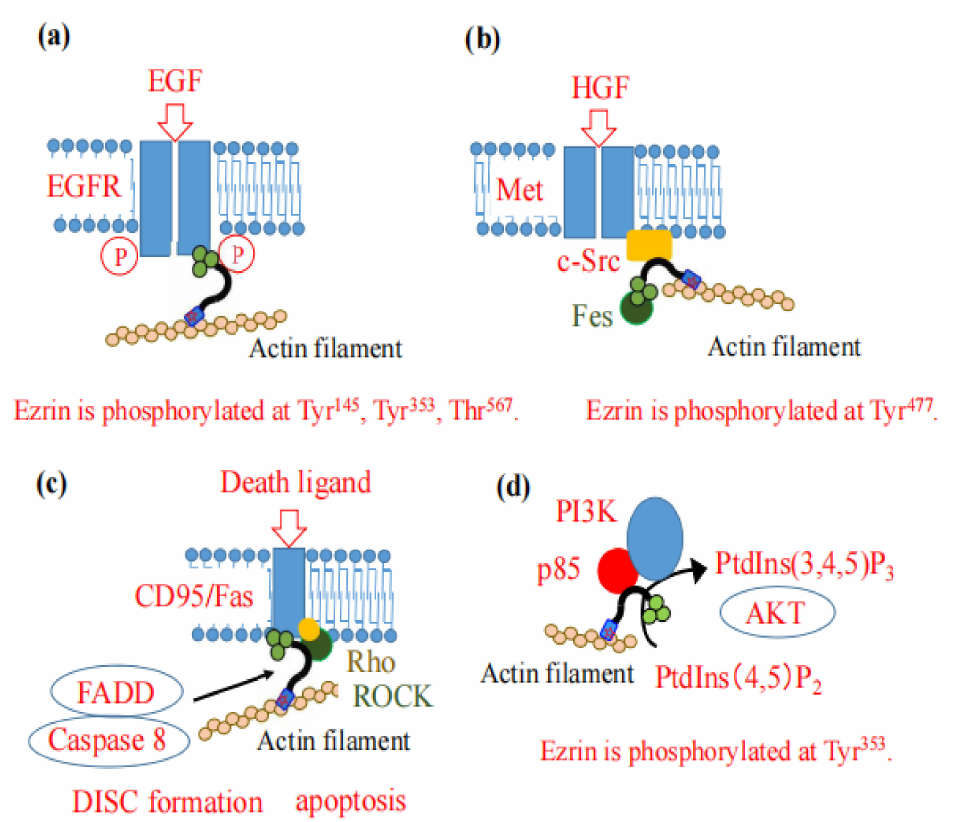
Figure 6. Ezrin is involved in several patterns of signal transduction. ( a ) In EGF signaling, ezrin cross-links the EGFR (shown by a couple of blue boxes) and actin filaments. In this process, ezrin itself is phosphorylated and activated by EGFR and other kinase(s) at Tyr 145 , Tyr 353 and Thr 567 . ( b ) In HGF signaling, HGF binds its receptor tyrosine kinase, Met (shown by a couple of blue boxes), which phosphorylates a non-receptor tyrosine kinase, c-Src (shown by a yellow box). Ezrin is phosphorylated by c-Src at Tyr 477 , and interacts with Fes tyrosine kinase (shown by a green circle). Thus, Fes is indirectly cross-linked with the actin cytoskeleton, recruited at the sites of cell-cell contact, and functions in cell invasion and metastasis. ( c ) Ezrin cross-links the receptor of death ligand, CD95/Fas (shown by a blue box), and the actin cytoskeleton, which is followed by the association of FADD and caspase 8 to form the DISC complex for apoptosis. Rho (shown by a yellow circle) and ROCK (shown by a green box) also associate with the complex. ( d ) Ezrin binds to the regulatory subunit of PI3-kinase, p85 (shown by a red circle). PI3-kinase synthesizes PtdIns(3,4,5)P 3 , which activates its downstream target, protein kinase AKT, and protects against